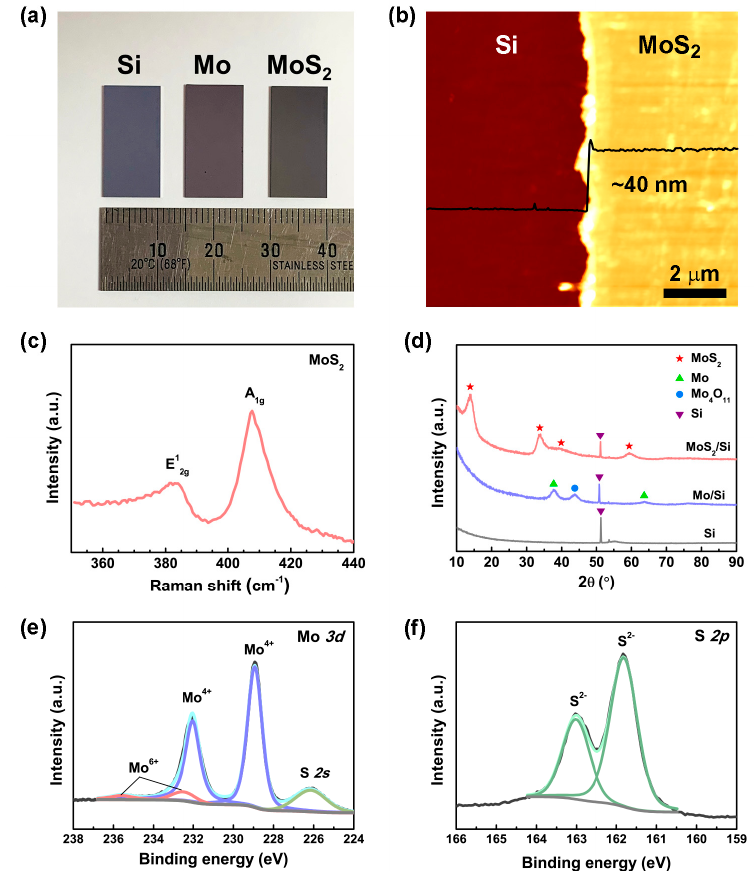
Figure 2. ( a ) Optical image of the Si substrate and Mo and MoS 2 films. ( b ) Contact-mode AFM image of MoS 2 and the relative height profile. ( c ) Raman spectra of the synthesized MoS 2 film on the Si substrate, with two peaks at 382.9 and 407.6 cm − 1 , corresponding to the E 1 2g and A 1g vibration modes, respectively. ( d ) XRD patterns of the bare Si, Mo film, and as-grown MoS 2 . XPS results for the synthesized MoS 2 film in the binding energy intervals of ( e ) Mo 3d and ( f ) S 2p .